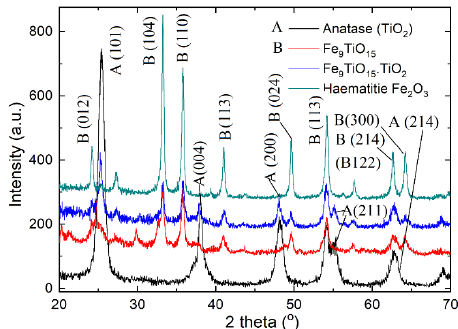
Figure 1. XRD patterns of Fe 9 TiO 15 @TiO 2 nanocomposites. Catalysts 2020 , 10 , x FOR PEER REVIEW